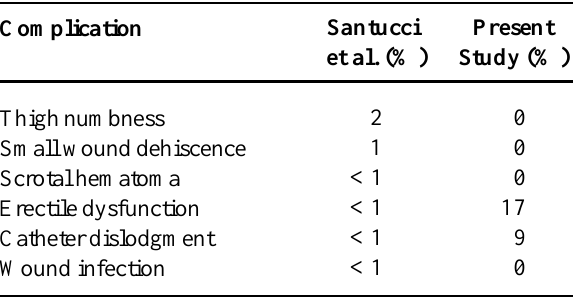
Table 6 – Comparing complications after anterior anas- tomotic urethroplasty in this study to 168 patients reported at the University of California San Francisco, Santucci et al. (ref. 2).